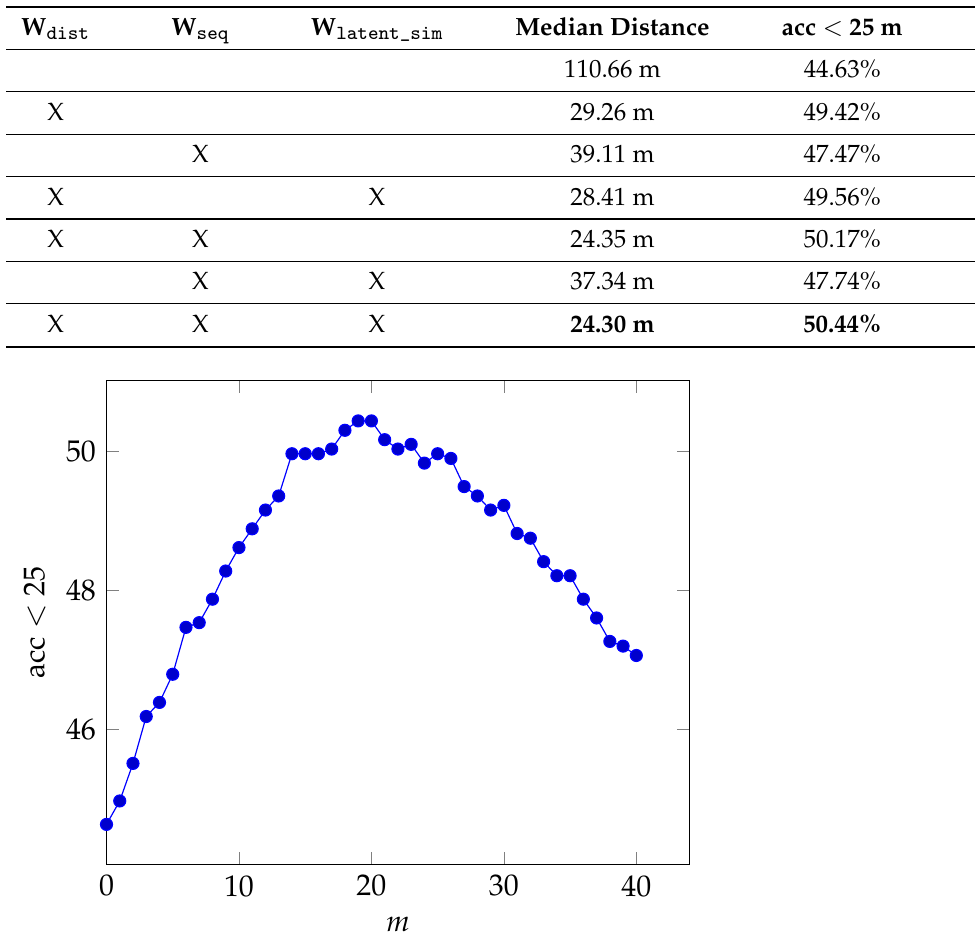
Table 4. Ablation study on the Mapiliary Adelaide test query. The best result per column is bolded.